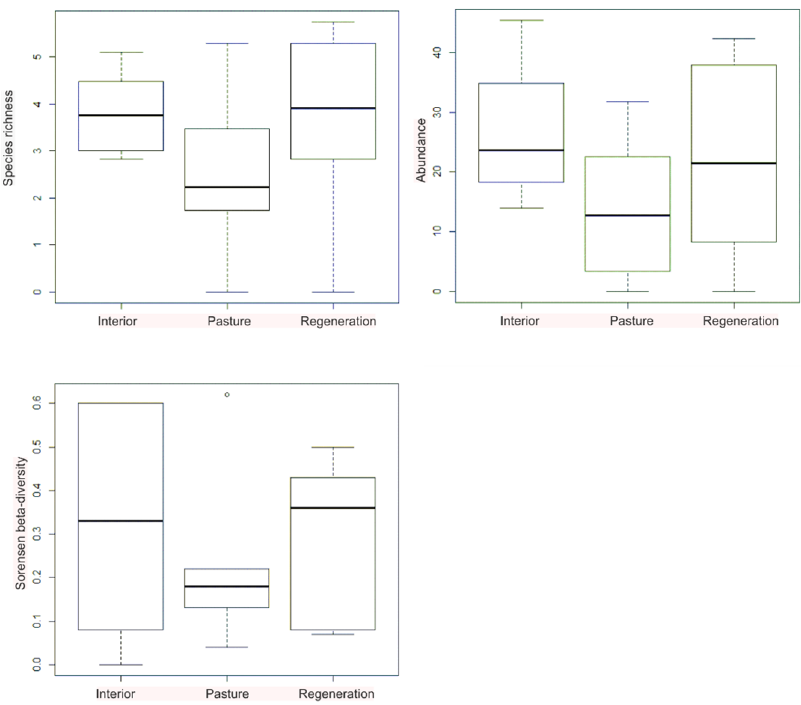
Figure 3. Orchid richness, abundance and beta diversity ( β SOR) within three sampling units. Whiskers show the standard deviation from the mean.